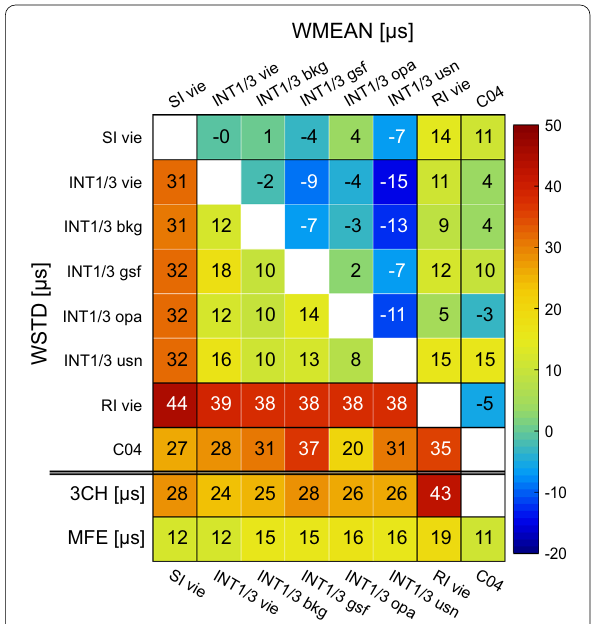
Fig. 8 Heatmap of comparison parameters for different UT1 time series. Right triangular matrix: weighted means (WMEAN) of UT1 UTC time series differences, sign convention is row minus − column. Left triangular matrix: weighted standard deviations (WSTD) of UT1 UTC time series differences. Bottom: UT1 − three-cornered hat analysis (3CH) and UT1 (MFE) of the different time series corresponding to the column labels. The colours visualise the range in addition to the values printed in the individual fields. All numbers are given in